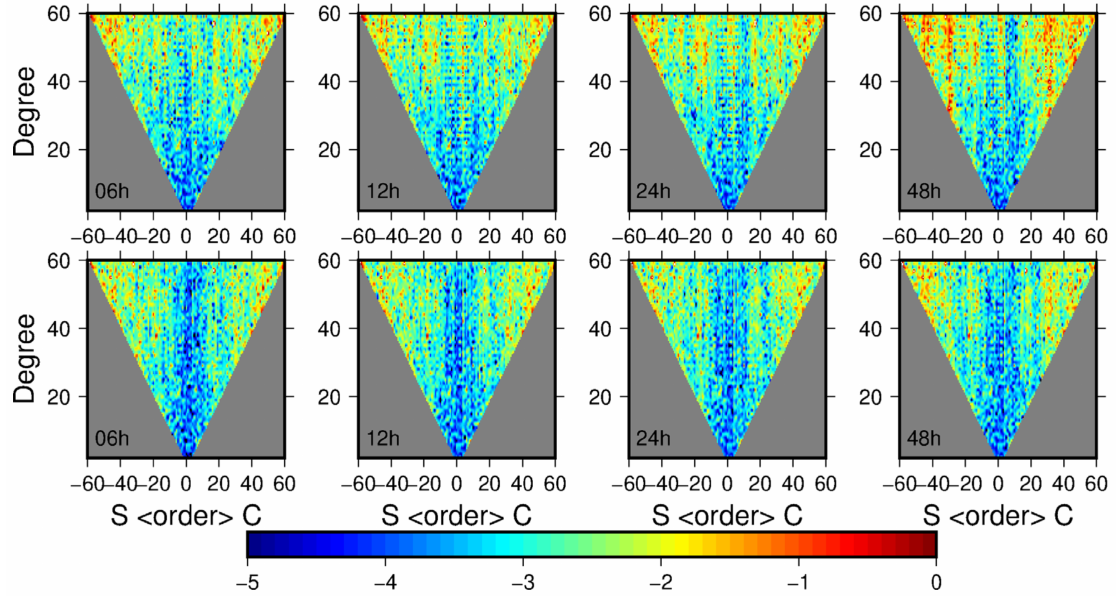
Figure 7. The logarithm of formal errors (comparing the EGM08) in the spherical harmonic coefficients of the recovered gravity field by using 6, 12, 24, and 48 h arcs, when combining the orbit and range rate to recover the gravity